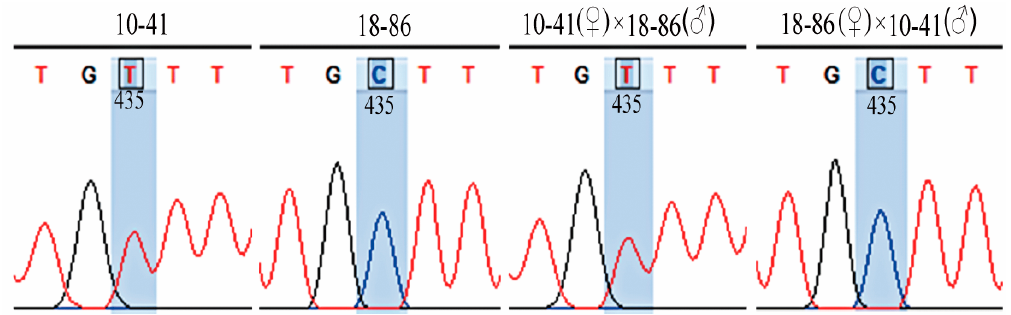
Figure 1. Monollelic expression of FvARI8 in reciprocal cross endosperm of two Fragaria vesca ecotypes. Sequencing showing that FvARI8 is a monollelic-specific gene, and expressed in a maternal parent-of-origin-dependent manner.